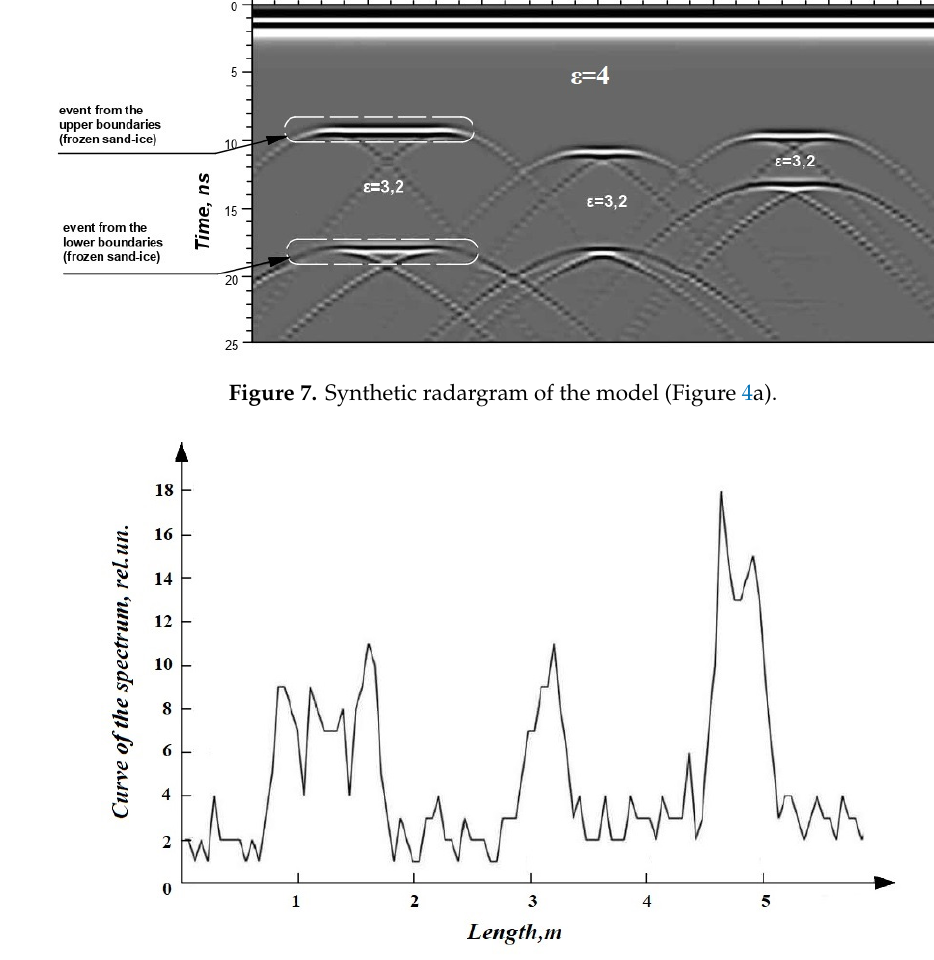
Figure 8. The result of calculating the “ripple” of the Fourier spectra of GPR traces of the radargram (Figure 7).